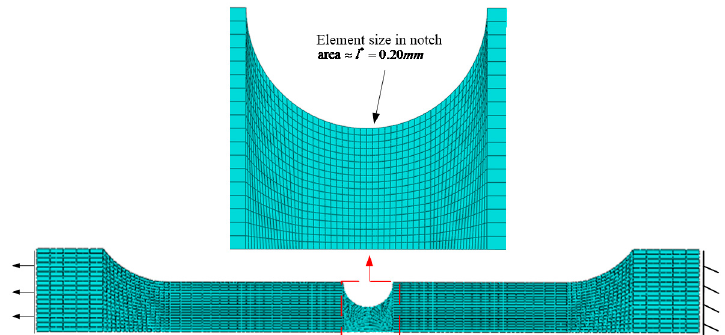
Figure 5. Axisymmetric finite element model of notched tensile specimen (R = 3.75 mm).